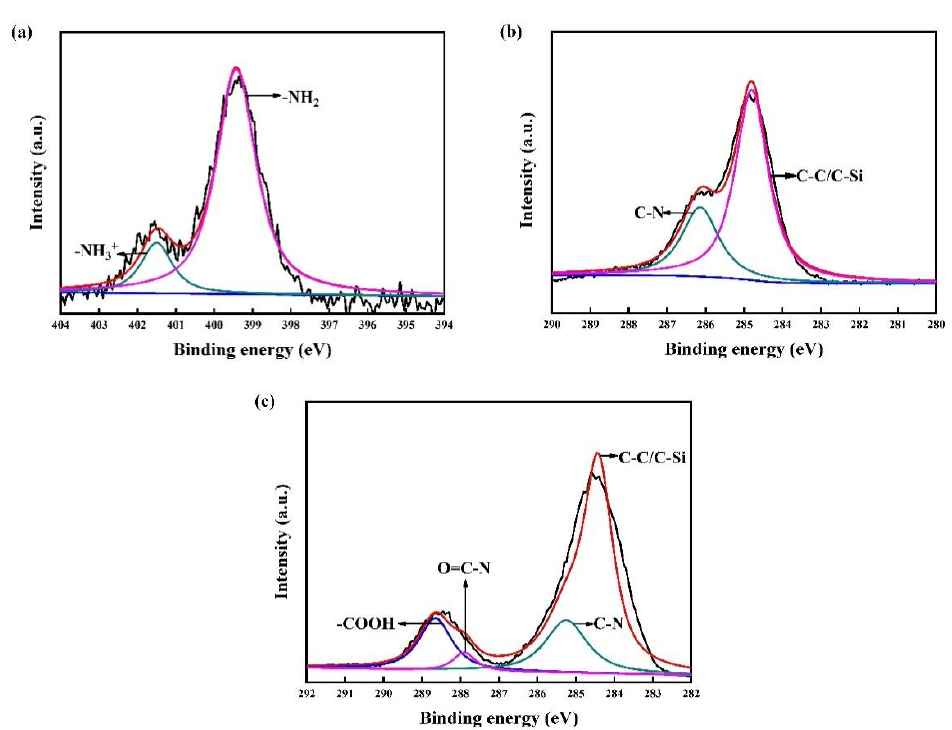
Figure 1. XPS patterns of the samples: ( a ) N1s peak of APTMS/SiO 2 /Si; ( b ) C1s peak of APTMS/SiO 2 /Si; ( c ) C1s peak of COOH-APTMS/SiO 2 /Si.